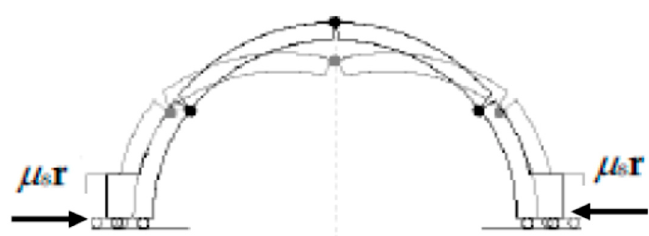
Figure 6. The released arch.